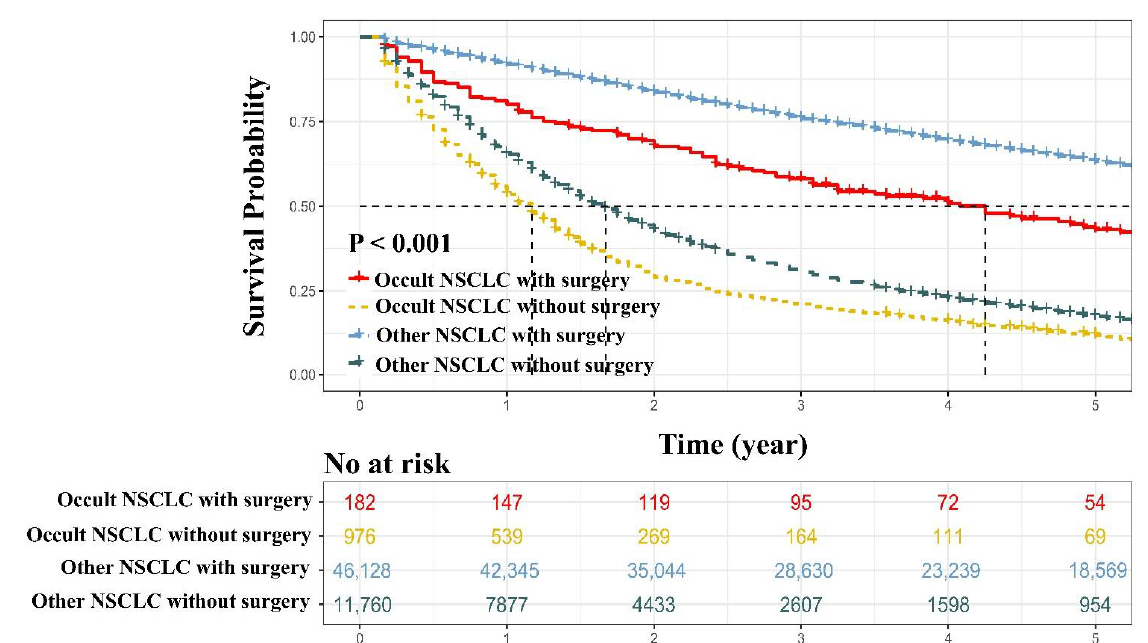
Figure 6. The overall survival comparisons. Occult NSCLC with surgery vs. occult NSCLC without surgery vs. other NSCLC with surgery vs. other NSCLC without surgery. NSCLC, non-small cell lung cancer.